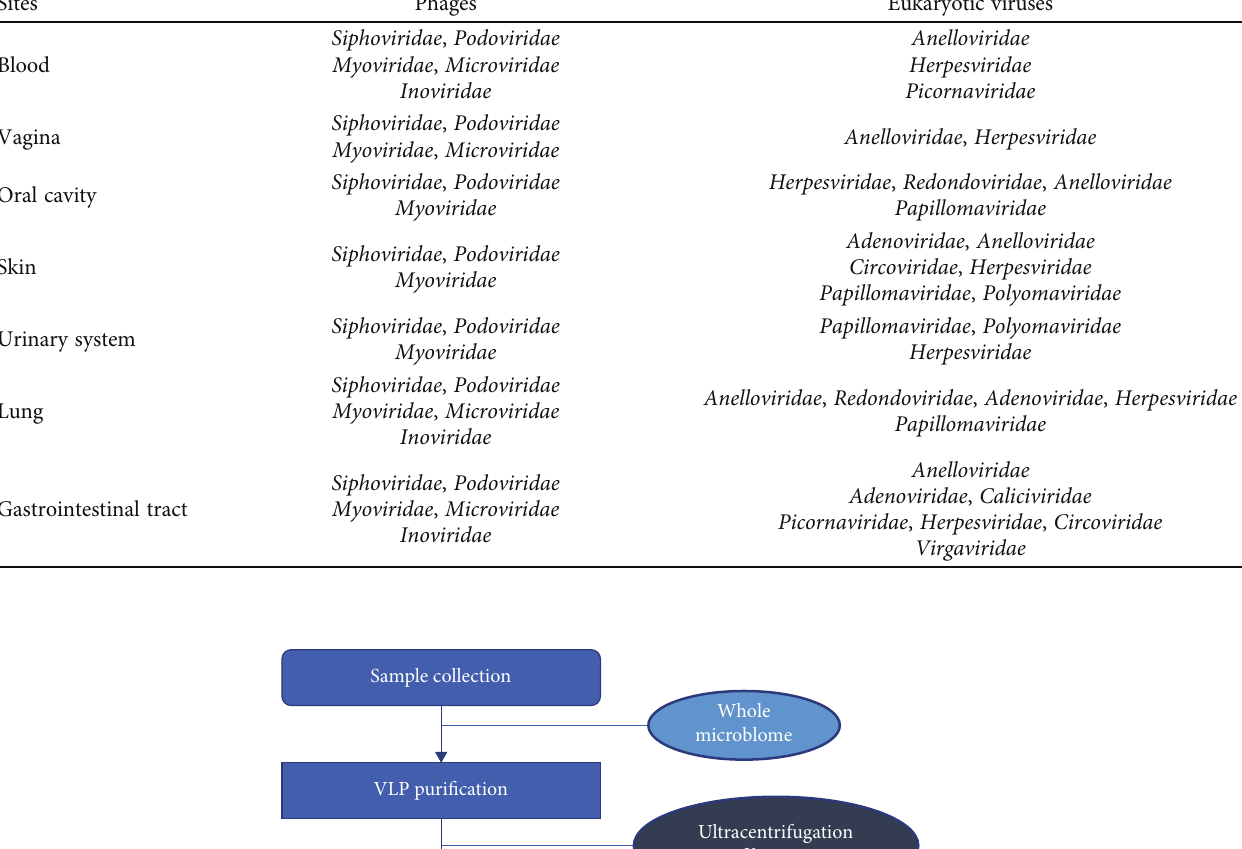
Table 1: Di ff erent body sites and the associated virome. A summary of the families of phages and eukaryotic viruses distributed at di ff erent sites in the human body (adapted from Liang and Bushman, [46]).